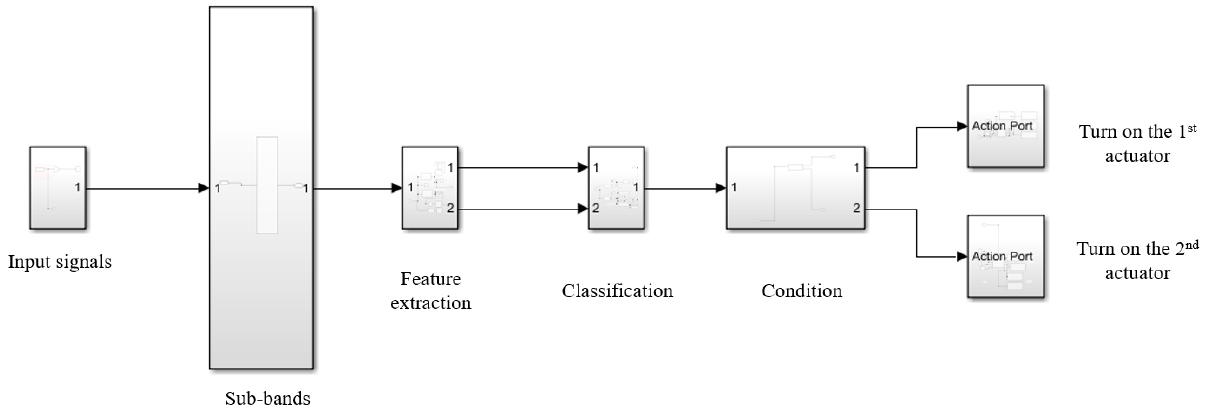
Fig.10. The Simulink